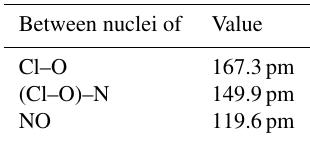
Figure 2. ClONO 2 UV absorption cross sections at 200K (dotted), 250K (dashed), and 296K